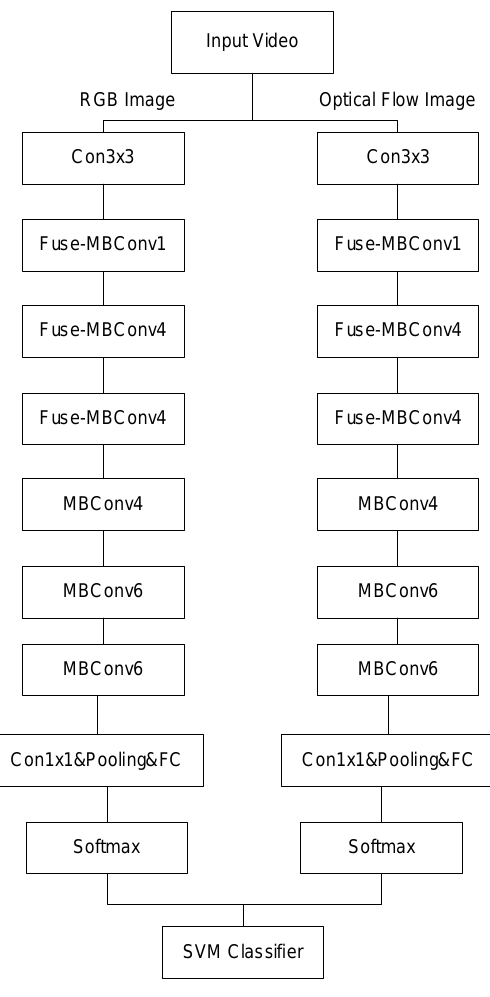
Figure 8. Action detection network structure.